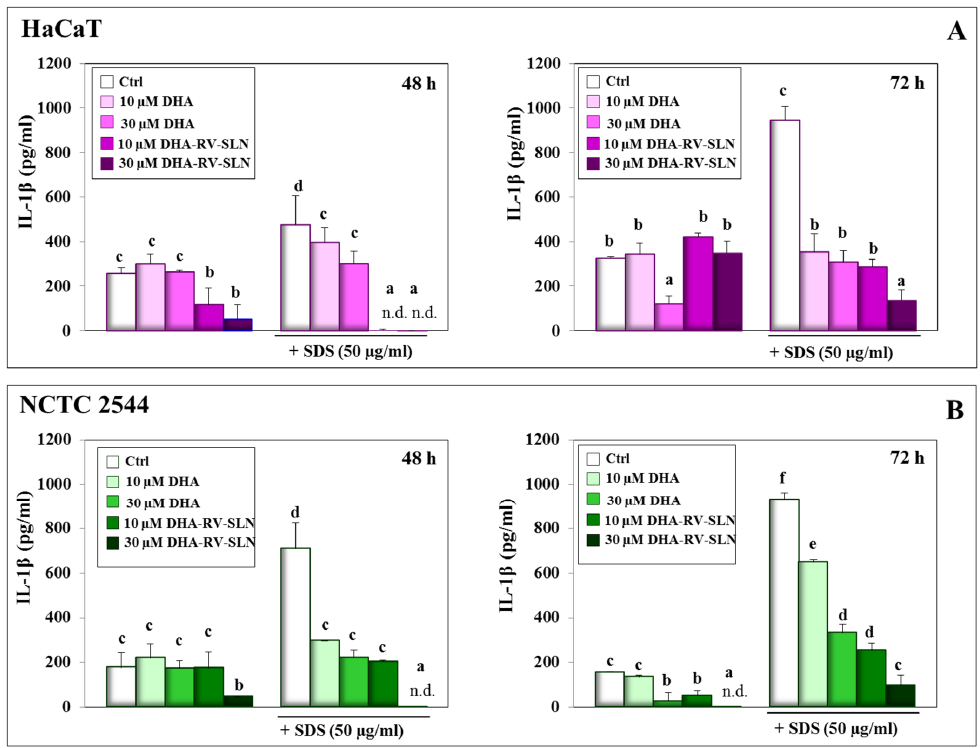
Figure 2. IL-1 β production in HaCaT and NCTC 2544 keratinocytes treated with SDS alone and in combination with DHA delivered or not through RV-SLNs. ( A ): HaCaT cells; ( B ): NCTC 2544 cells. The cells were treated with free DHA or DHA-RV-SLNs (10 or 30 μ M) in the absence or in the presence of 50 μ g/mL SDS for 48 (left panels) or 72 h (right panels). Data are the means ± SD of three different experiments. Values not sharing the same superscript letter are significantly different ( p < 0.05, one-way ANOVA followed by Tukey’s test).